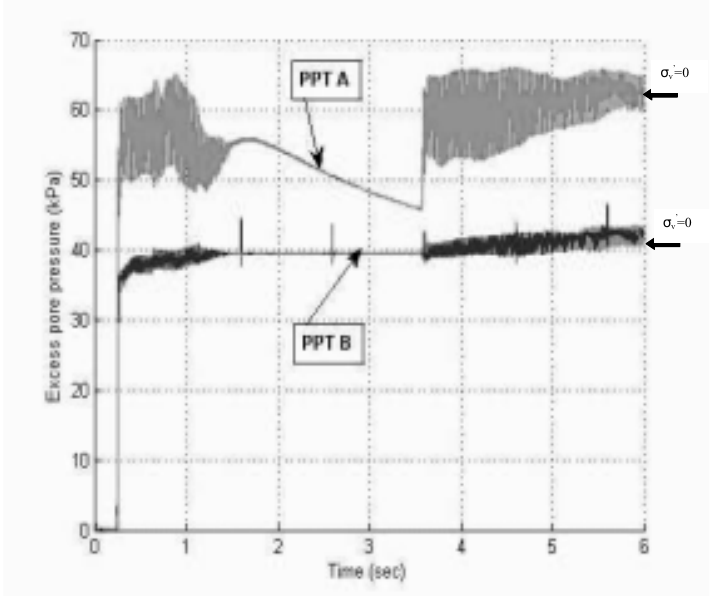
Fig. 7. Excess pore pressure generation and dissipation in the test.